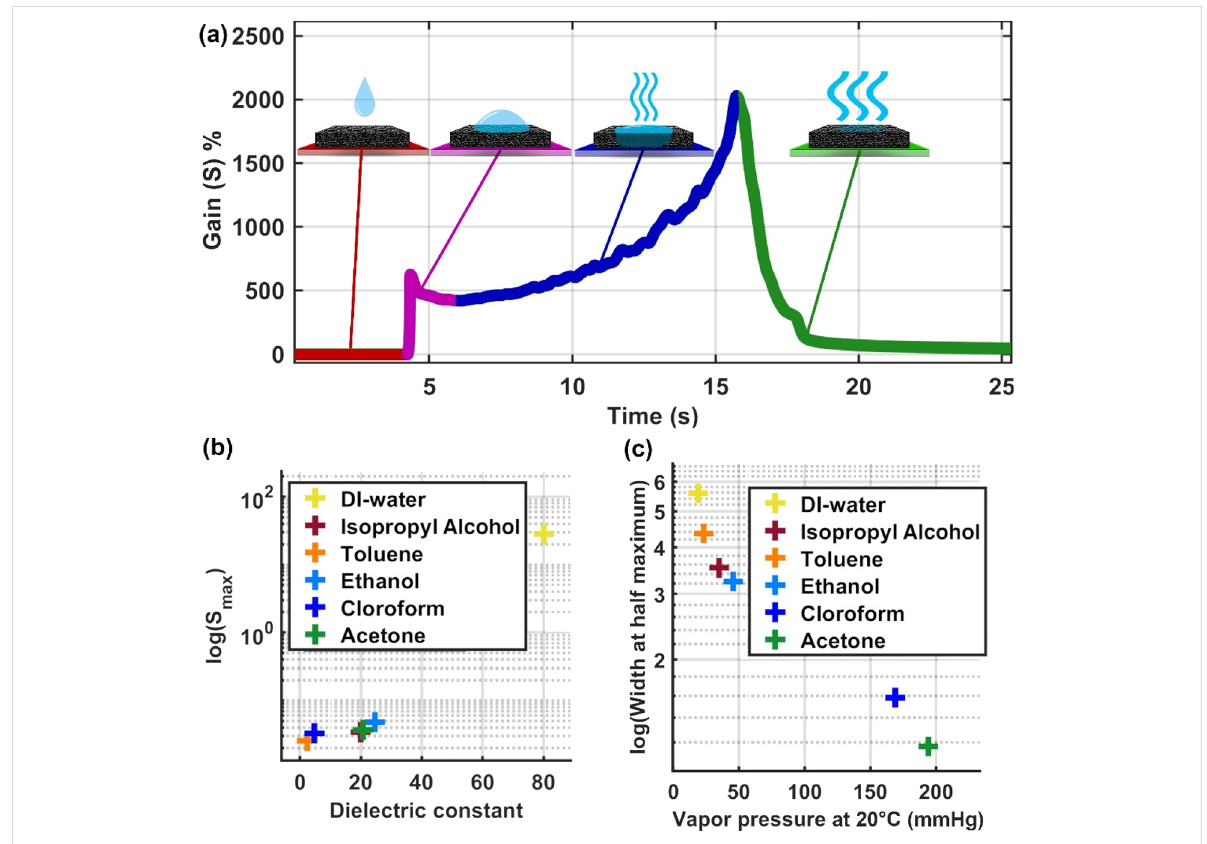
Figure 4: (a) Sketch depicting the step-by-step process of sensing. (b) Correlation between the dielectric constant of the tested solvents and the maximum gain obtained from the Gain curves shown in Figure 3. (c) Correlation between the vapor pressure of the tested solvents and the width at half maximum (FWHM) obtained from the Gain curves shown in Figure 3.